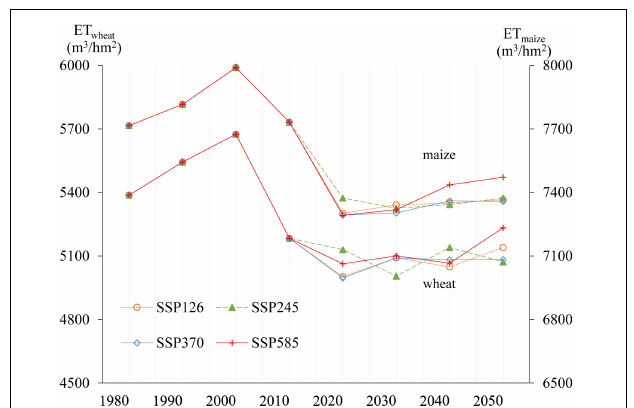
FIGURE 6 | Crop water requirement per unit area ( E T c ) of wheat and maize in Zhangye under different SSP-RCP scenarios during 1980–2050.